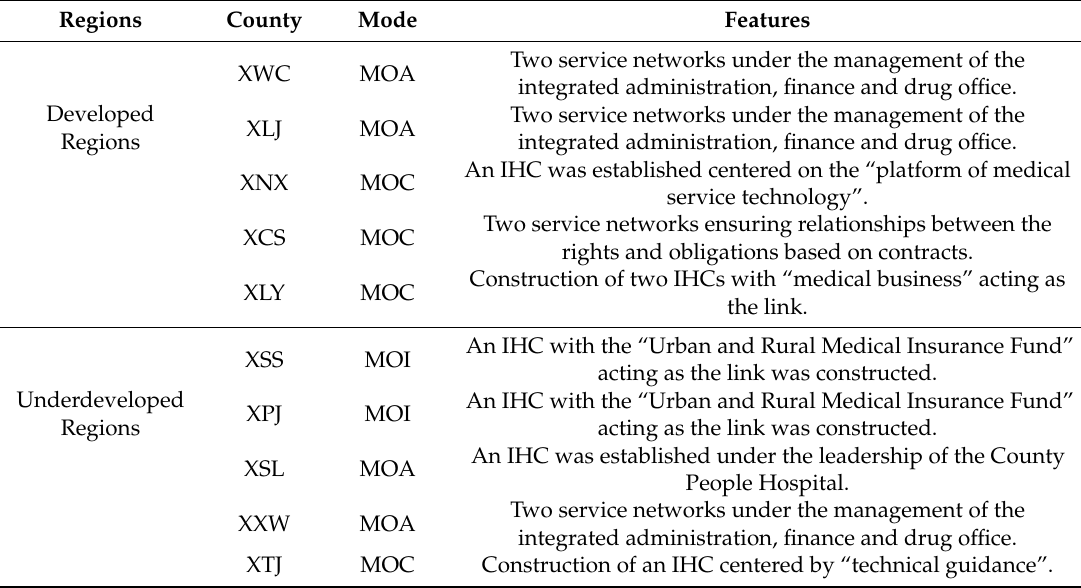
Table 3. Distribution of sample